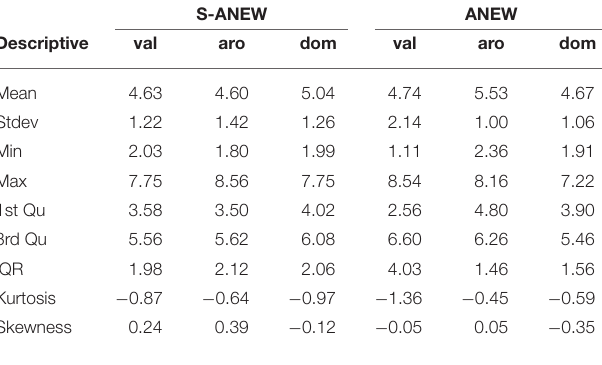
TABLE 1 | Comparison of descriptive statistics between Spanish S-ANEW and Redondo et al. (2007) ANEW. S-ANEW ANEW